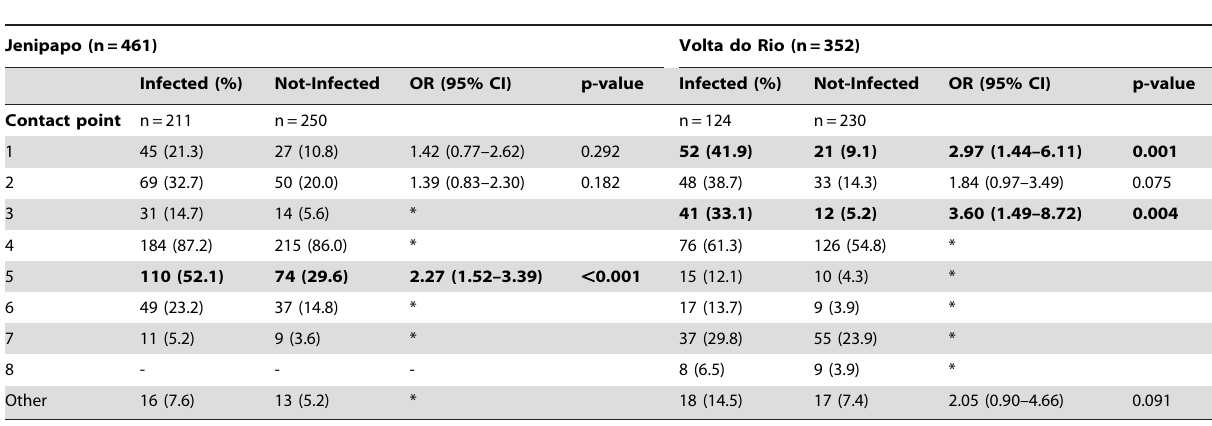
Table 3. Risk at water contact points for S. mansoni